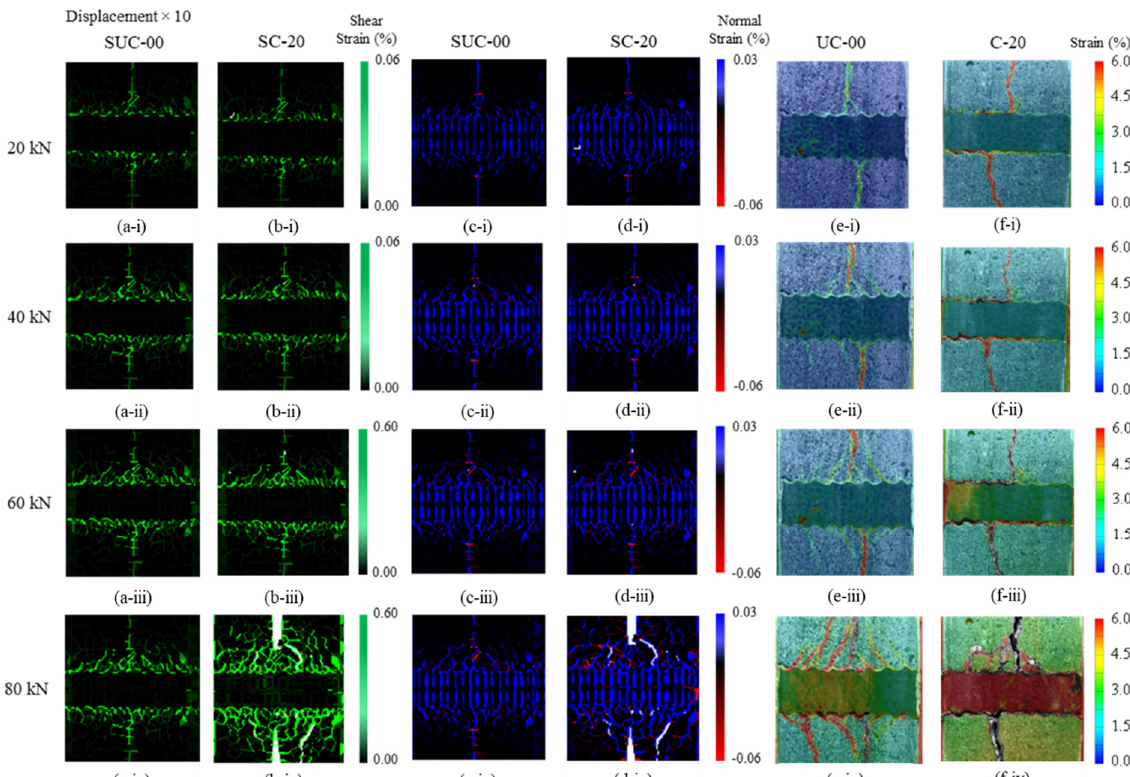
Figure 9. Change of strain distribution with loading in uncorroded and corroded cases ( a , b ) shear strain in simulation, ( c , d ) normal strain in simulation, ( e , f ) observed using digital image correlation (DIC) in experiment.